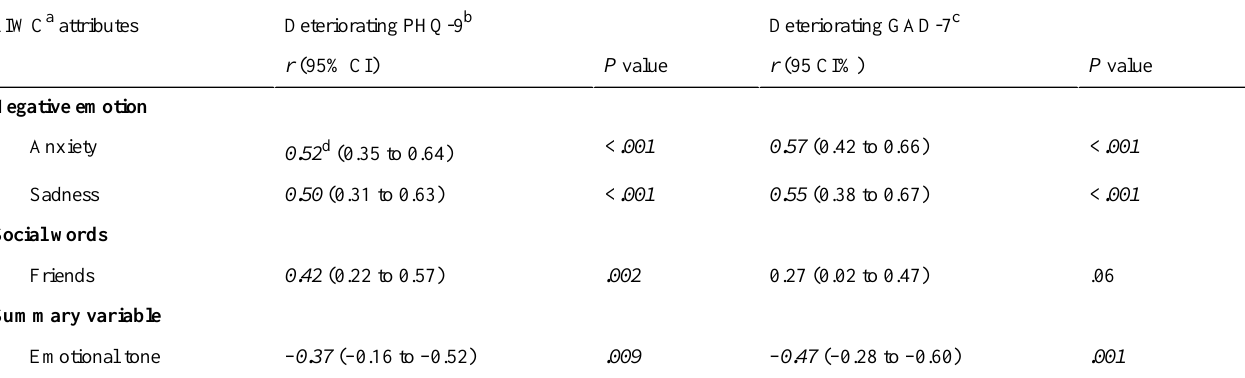
Table 5. The significant LIWC features from YouTube videos and their correlation coefficients with deteriorating PHQ-9 and GAD-7